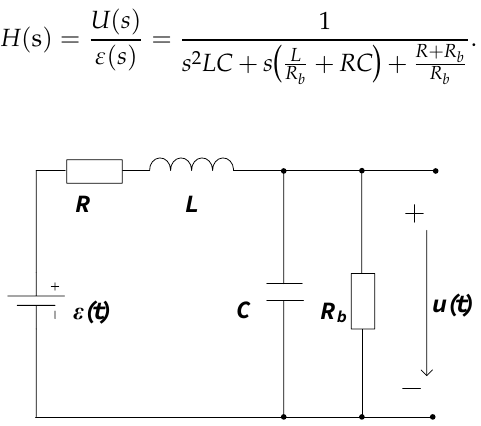
Figure 3. Equivalent circuit model of the receiver coil.